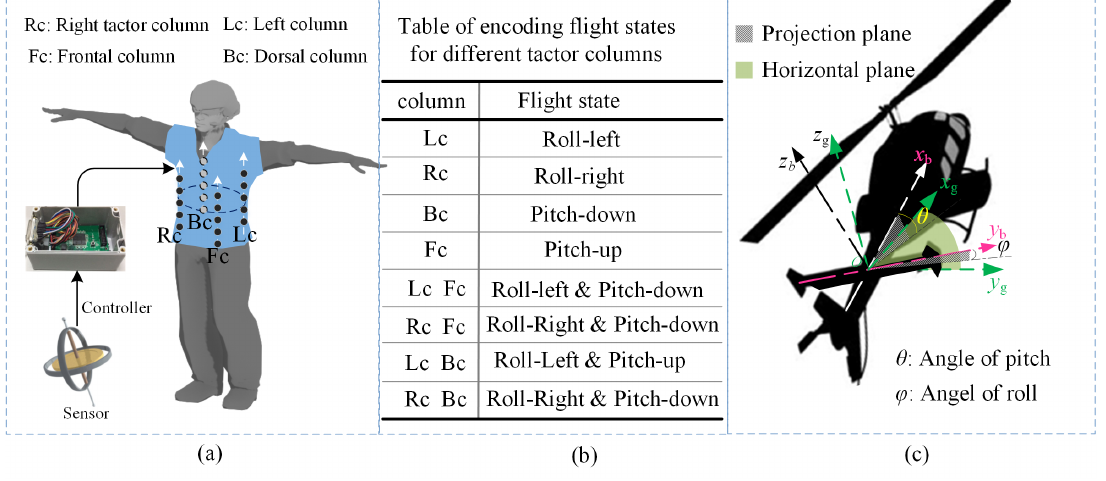
Figure 3. Overview of vibrotactile system for cueing flight attitude. ( a ) System block diagram of vibrotactile TSAS and Tactor arrangement around the torso of pilot. The controller receive flight attitude information from the geomagnetic sensor and activate vibrotactile vest to vibrate in the pattern corresponding to the attitude; ( b ) Schematic diagram of encoding flight states for different tactor columns; ( c ) Definition of Flight attitude information of aircraft.